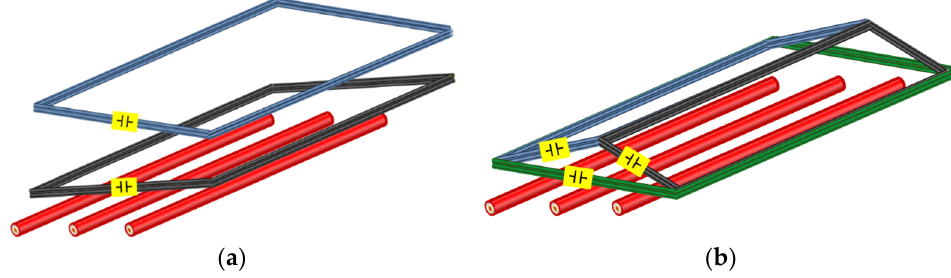
Figure 7. Two examples of passive loops arrangements, as follows: ( a ) Independent series-compensated loops and ( b ) enchained series-compensated loops over a power line.